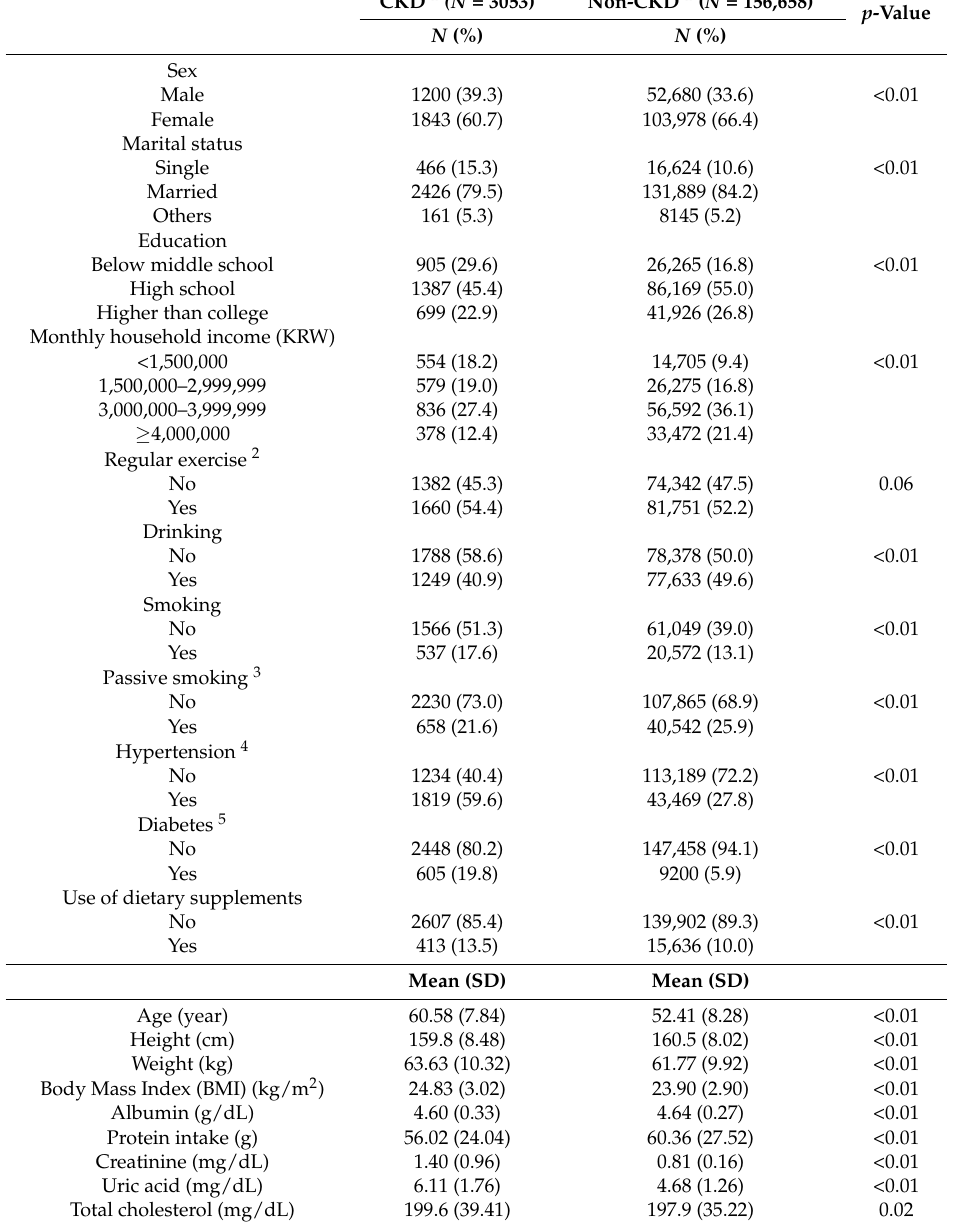
Table 1. General characteristics of the study population stratified by chronic kidney disease (CKD) 1 status in the Health Examinees Study (HEXA) of a major urban cohort in the Korea Genome and Epidemiologic Study (KoGES),